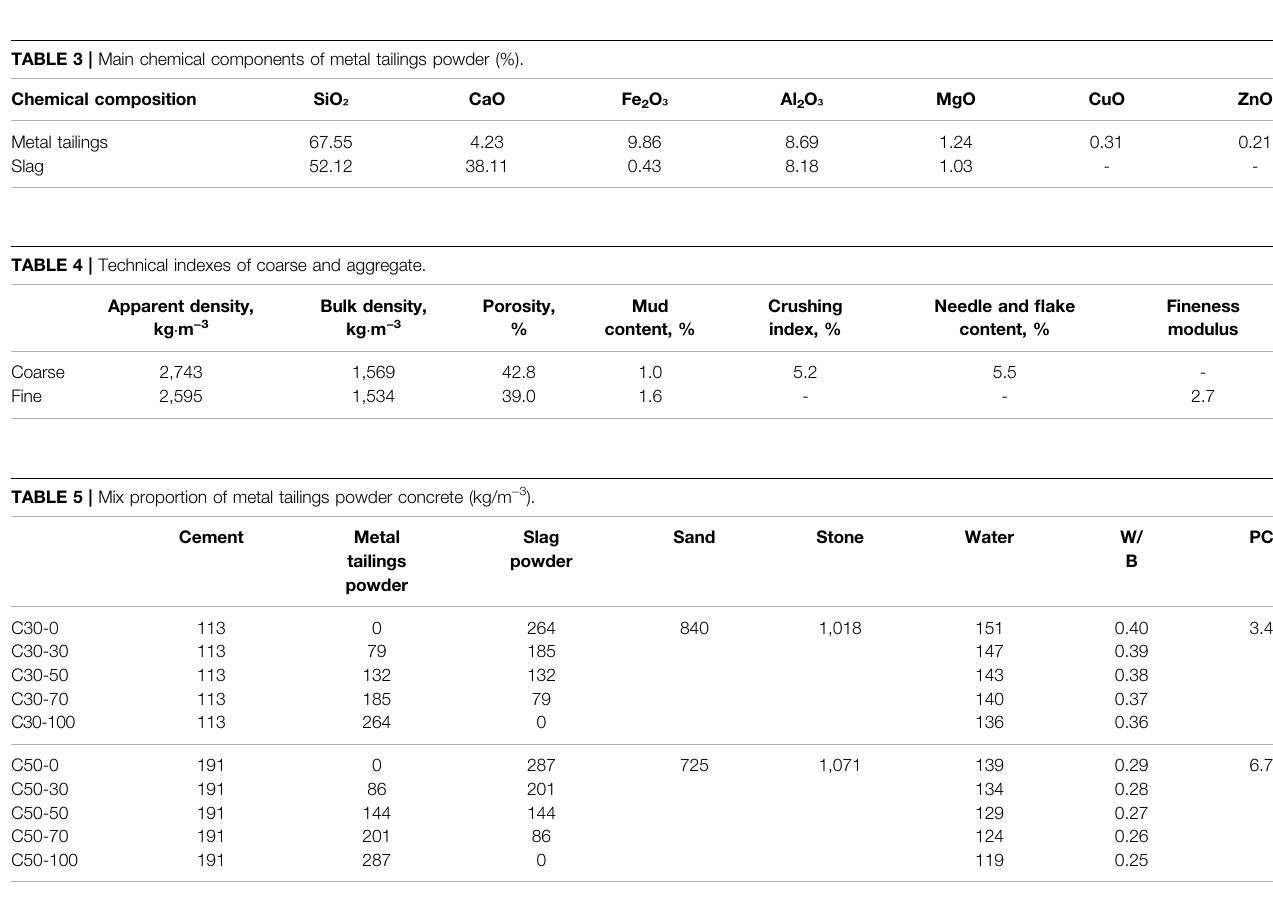
Figure 1 . The relative compressive strength factor is calculated, and the results are shown in Table 6 .